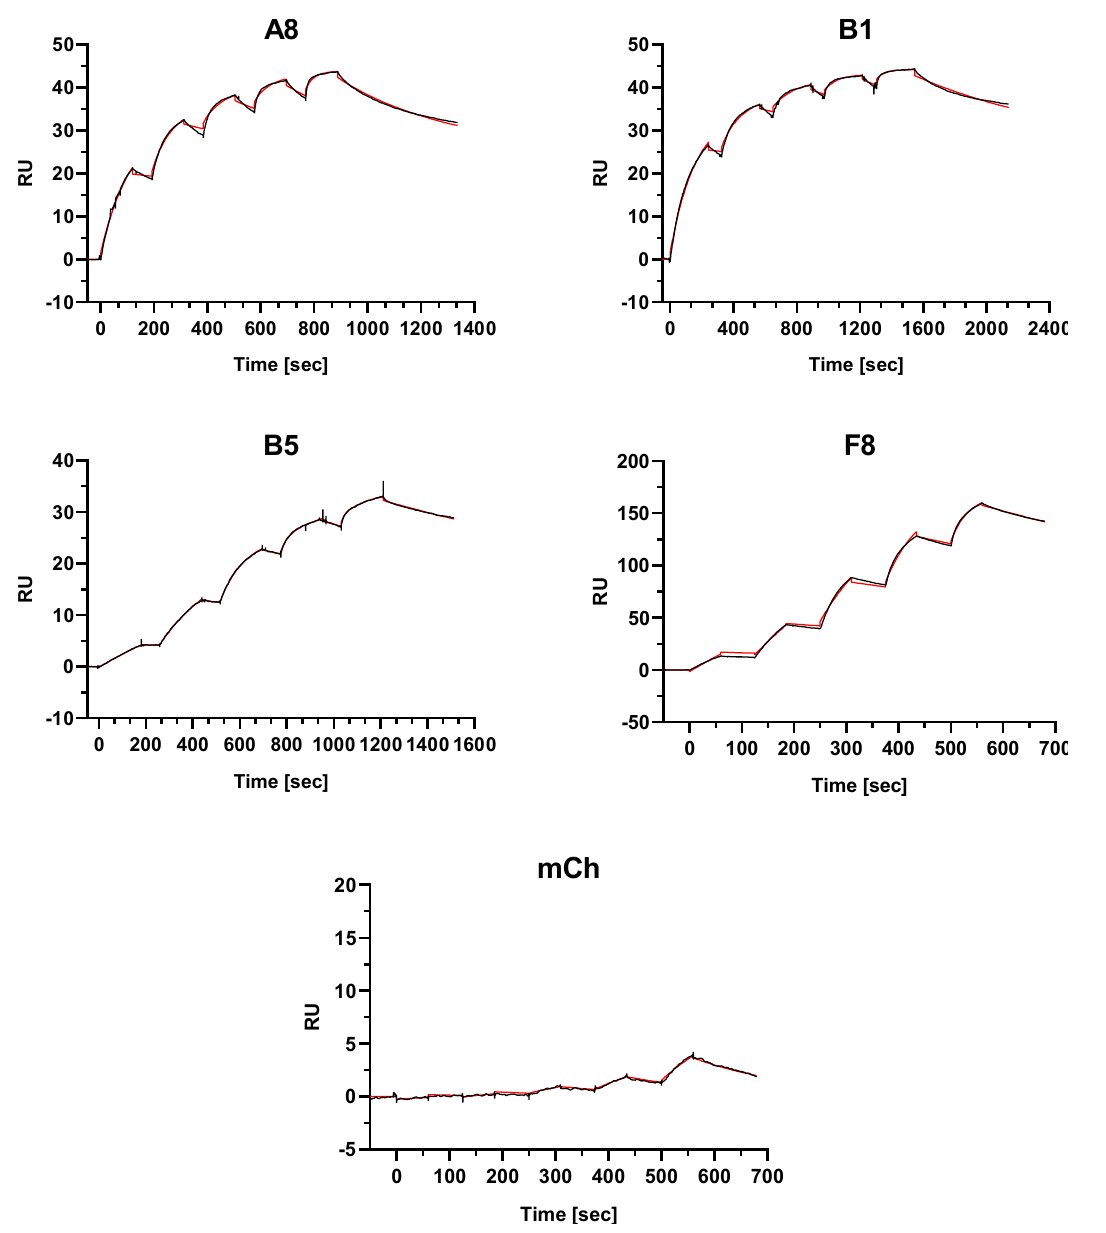
Figure 3. A ffi nity determination of sdAb to recombinant protein via surface plasmon resonance spectroscopy. Single-cycle kinetics analysis was performed on immobilized FGFR4 through covalent amine binding on the dextran-based sensor chip. The analytes A8, B1, B5, F8 and mCh were injected in 5 di ff erent concentrations followed by a dissociation phase. A final dissociation step was added after the last injection step to determine K o ff rates for the KD calculations representing binding a ffi nities. The black curves represent the measured data and red curves show the fit analysis (heterogeneous ligand model) performed with the BIAevaluation